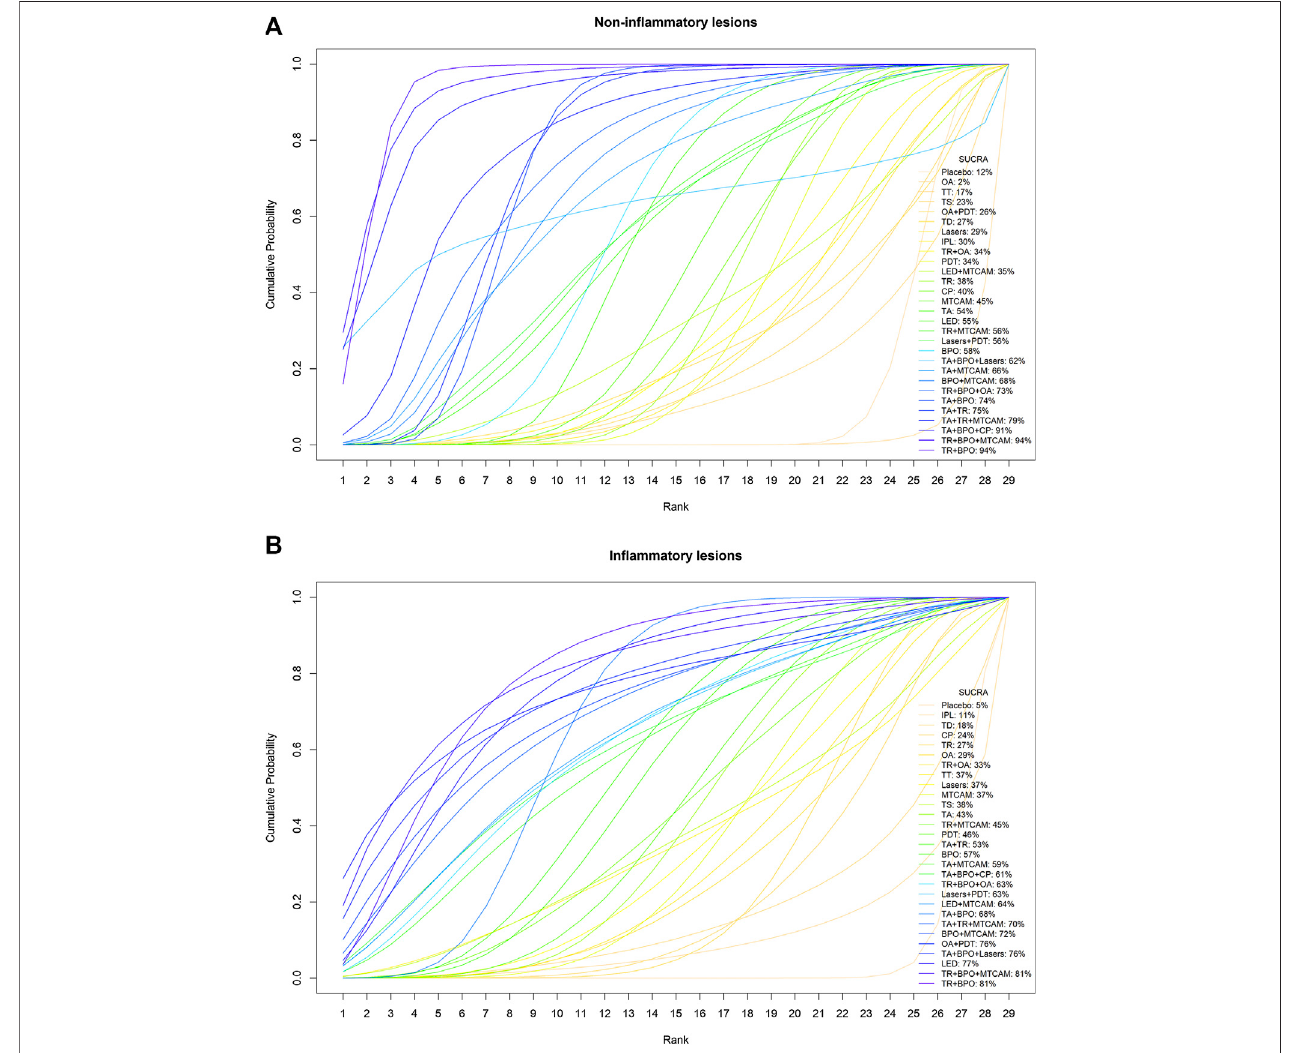
FIGURE 3 | Cumulative probability curves and SUCRA values. (A) Nonin fl ammatory lesions count. (B) In fl ammatory lesions count.